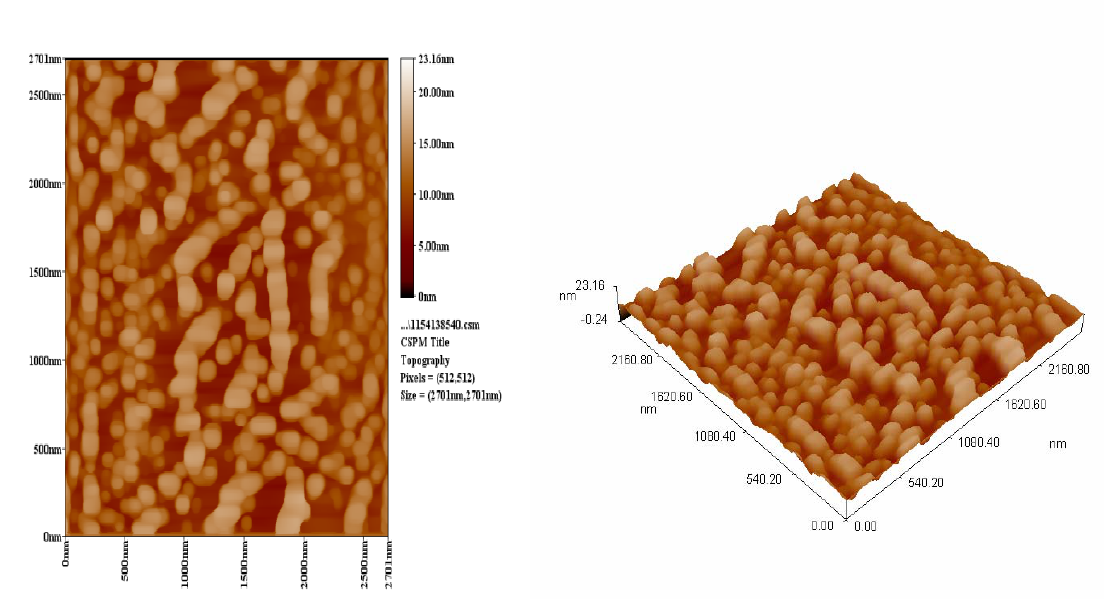
Fig. 6: AFM micrograph showed uniformity and a three-dimensional surface profile of 0.03 MgO nanospheres in the epoxy